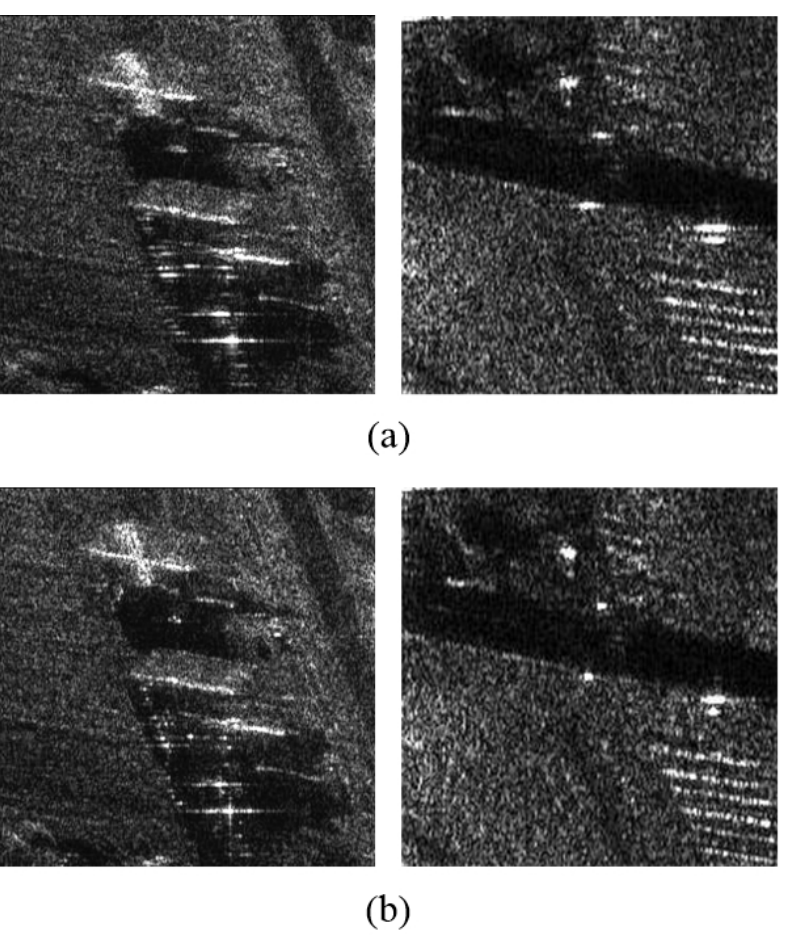
Figure 8. Local scene amplification imaging comparisons. ( a ) Processed by CSA+ANLCS; ( b ) Processed by proposal+ANLCS.